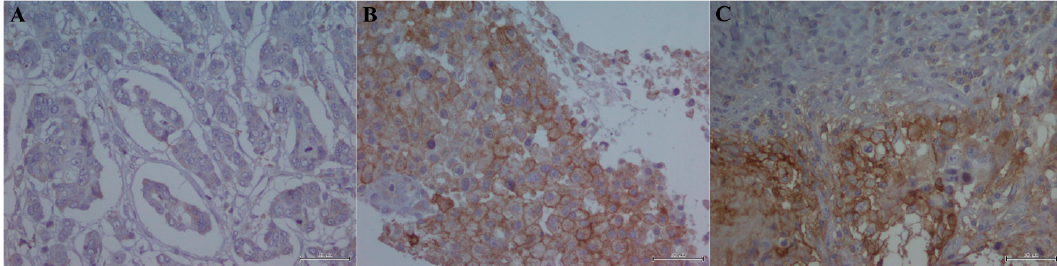
Figure 1. PD-L1 immunostaining in TNBC cells: ( A ) “Score 0”, detail of absence of membranous immunoreactivity (magnification 40×); ( B ) “Score 1”, detail of incomplete membranous positivity with basolateral and/or with semicircular bars (magnification 40×); and ( C ) “Score 2”, detail of complete membranous positivity (magnification 40×).